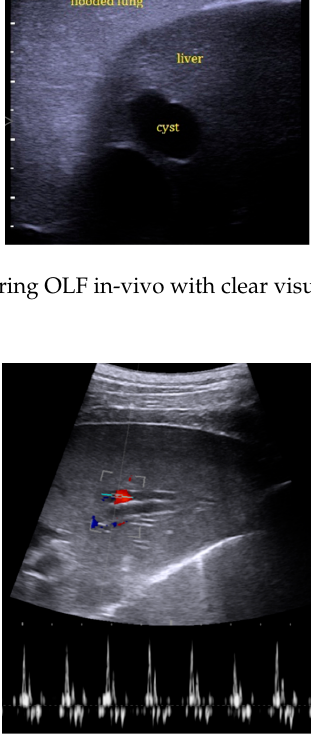
Figure 6. Sonographic imaging of hypoechoic Non-Small-Cell Lung Carcinoma (NSCLC) in saline flooded lung using ex-vivo human lung models (With permission from Lesser et al. [18]). Figure 7. Endobronchial sonographic imaging of intrapulmonary nodal metastasis in saline flooded lung using ex-vivo human lung models. 3.3. Clinical Relevance So far, OLF in-vivo was been performed only using large animal models. The promising imaging results have not brought OLF into clinical practice. Therefore, consecutive work investigated minimal invasive procedures, which justified OLF. Herein, sonographic guided tissue